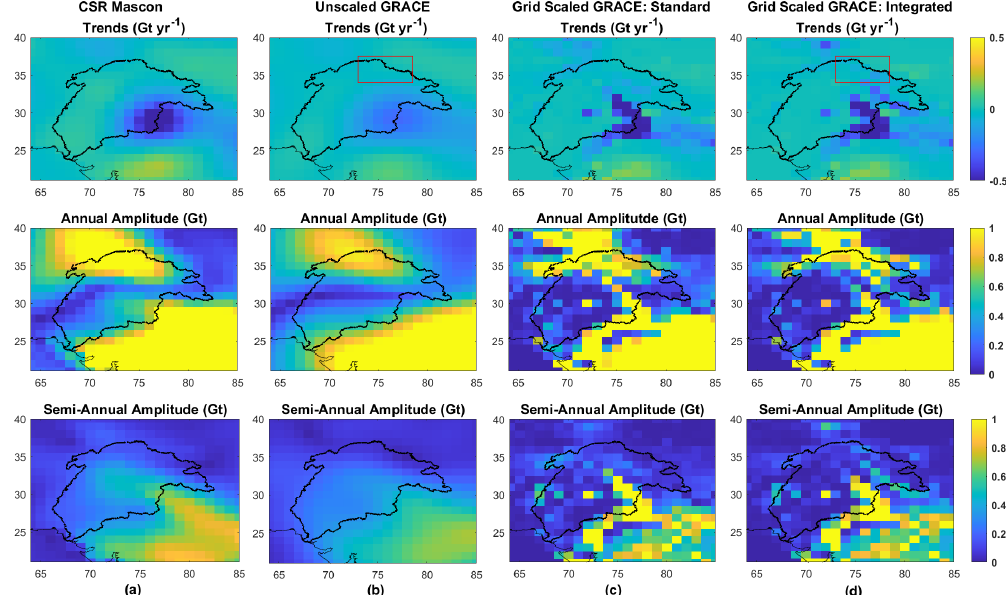
Figure 13. Spatial distributions of the components mass anomalies from (a) CSR MASCONS, (b) unscaled SH solutions, (c) grid-scaled SH solutions using standard, and (d) grid-scaled SH solutions using integrated WGHM (left to right panels) in the Indus Basin. The red bounding box indicates the extent of the Karakoram region.